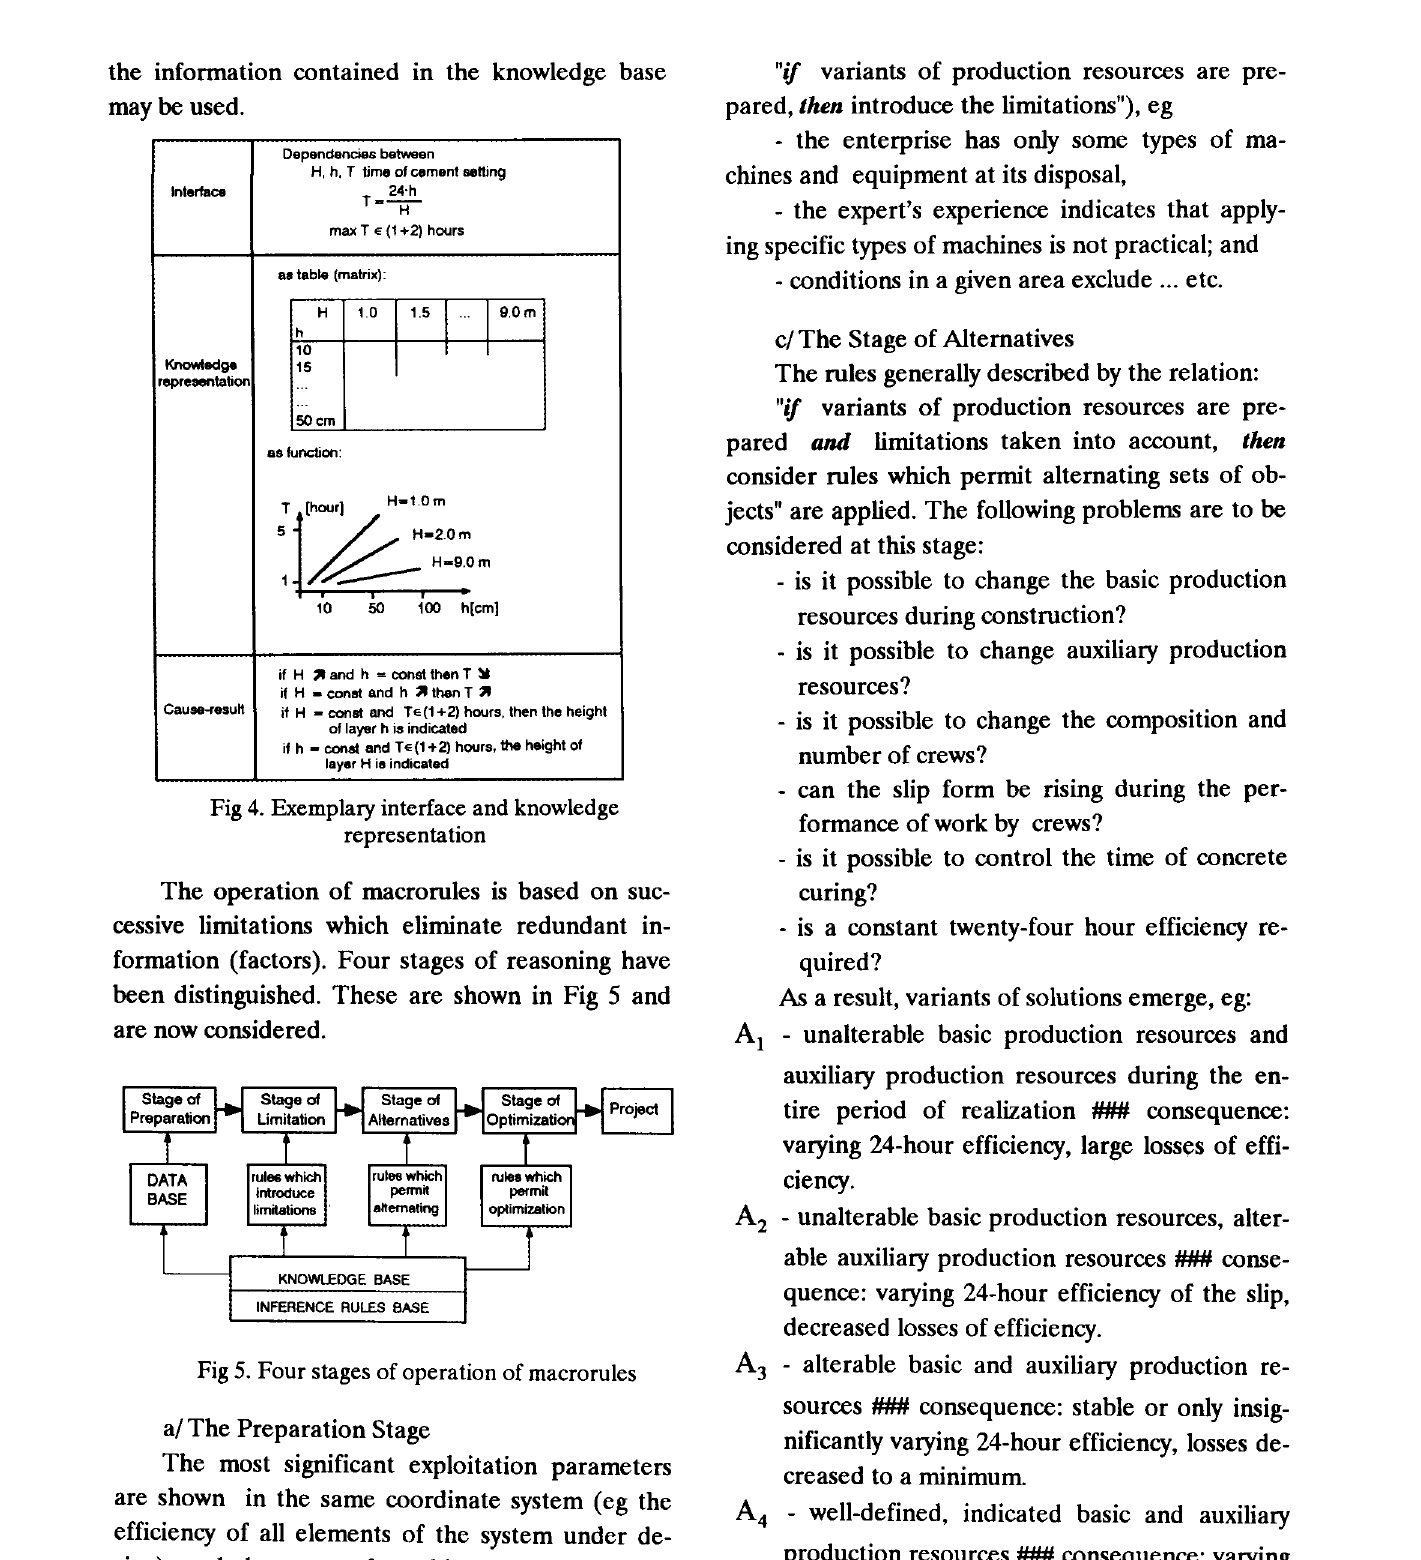
Fig 5. Four stages of operation of